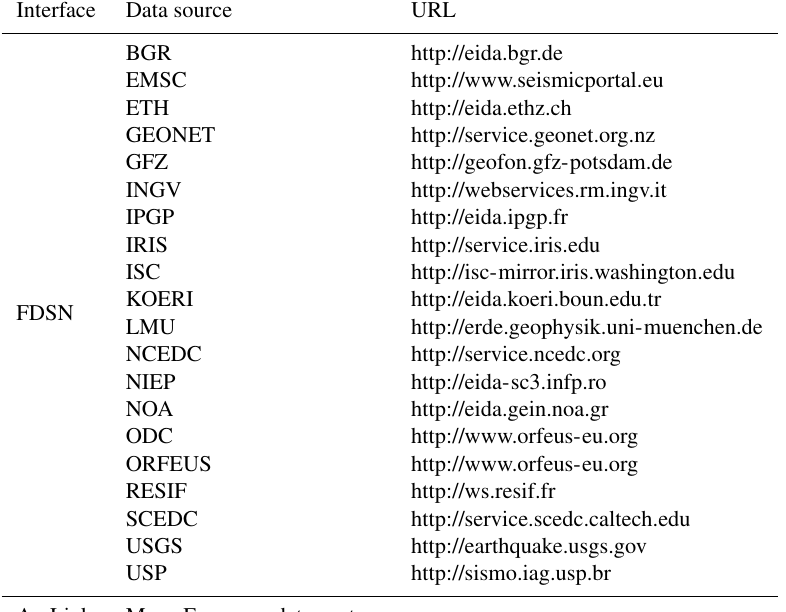
Table 3. List of international data centers that can be currently accessed via FDSN and ArcLink interfaces of obspyDMT. This list is growing as more and more data centers can be accessed directly (as opposed to FTP or email-based methods). obspyDMT --print_data_sources lists all available data centers, and --print_event_catalogs lists all available event